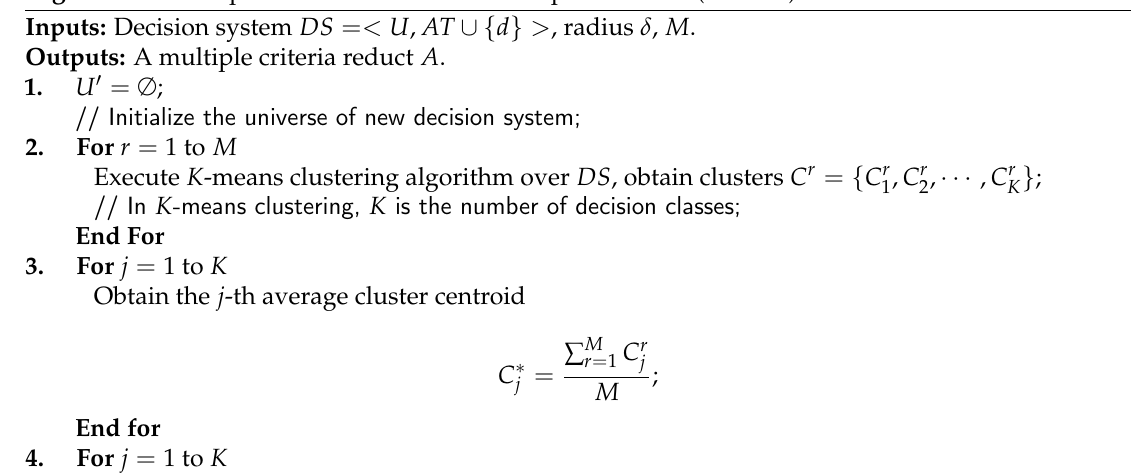
Algorithm 4 Multiple-Criteria Reduct with Sample Selection